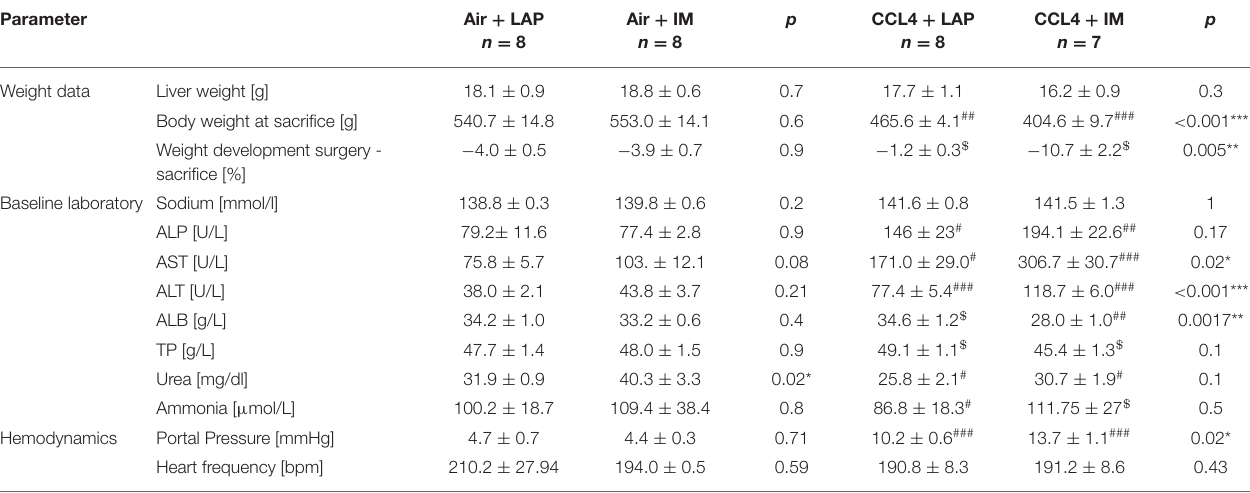
TABLE 1D | General characteristics and clinical data of rats receiving AIR/CCL4 at sacrifice 7 days after IM/LAP. Parameter